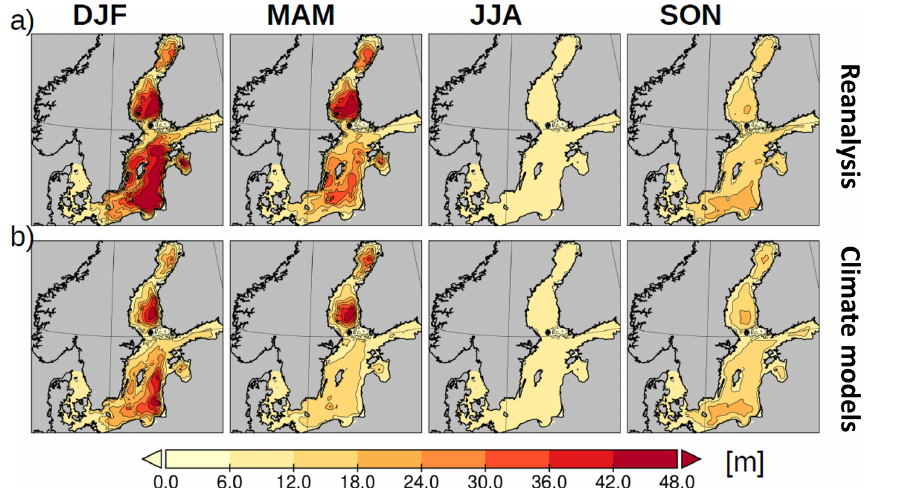
Figure 5. Mixed-layer thickness calculated according to the criterion following de Boyer Montégut et al. (2004). (a) Reanalysis data (Liu et al., 2017). (b) Ensemble mean over the four models (Saraiva et al., 2019a). Shown are the averages during 1976–1999.